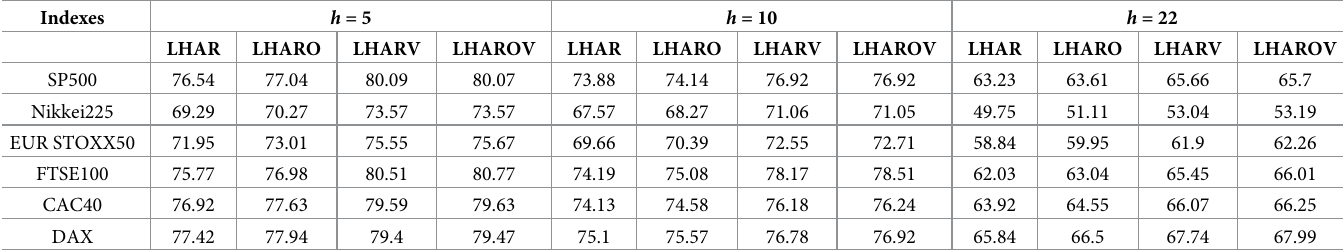
Table 6. Adjusted R-square of LHAR, LHARO, LHARV and LHAROV (in percentage terms).